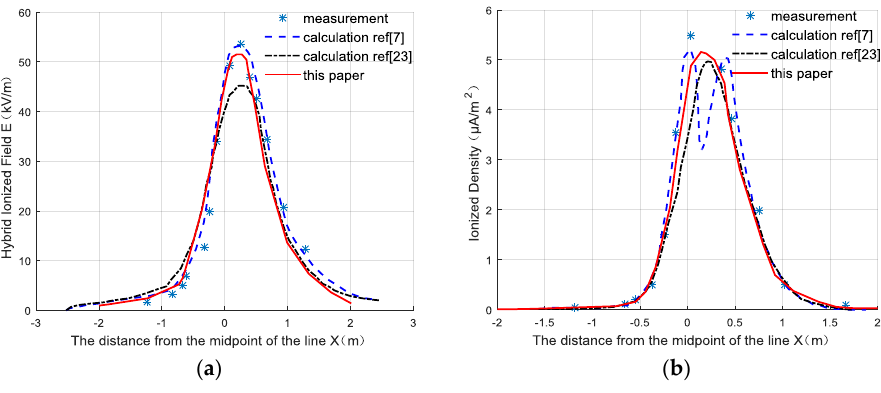
Figure 5. Comparison of calculation. ( a ) Hybrid ionized field. ( b ) Ion current density.